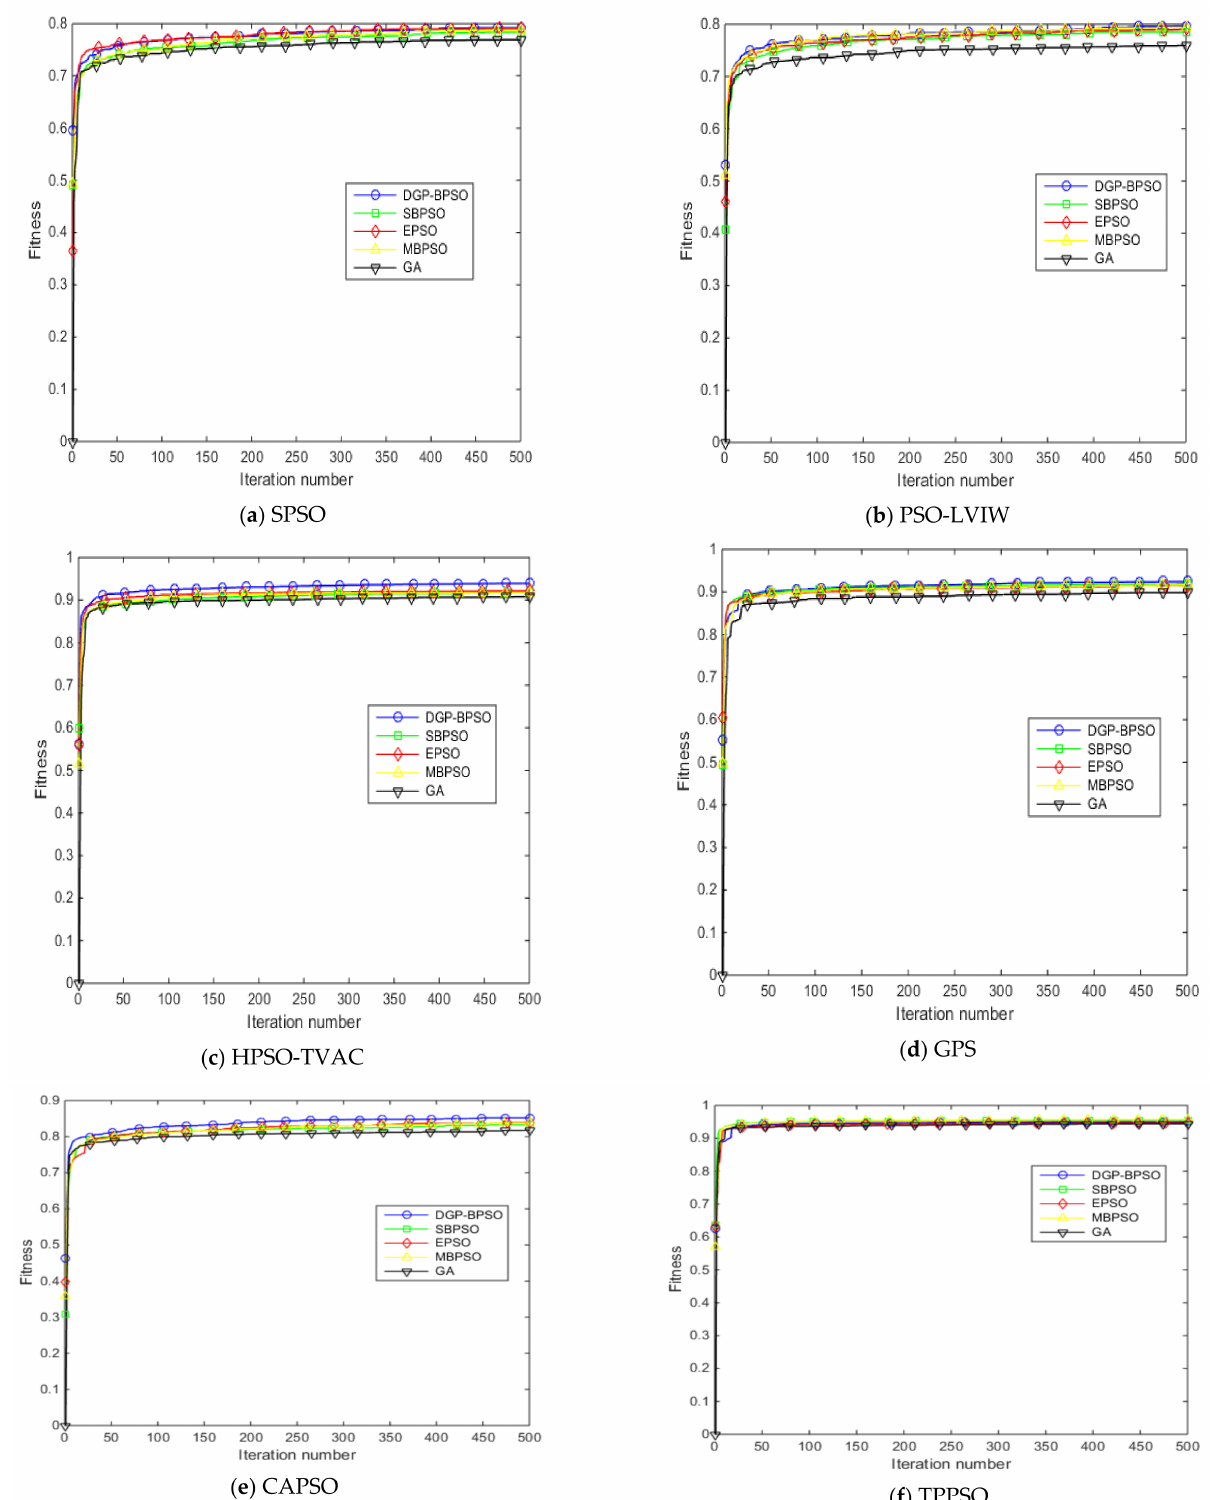
Figure 6. Convergence graphs of the hybrid PSO variants for power savings